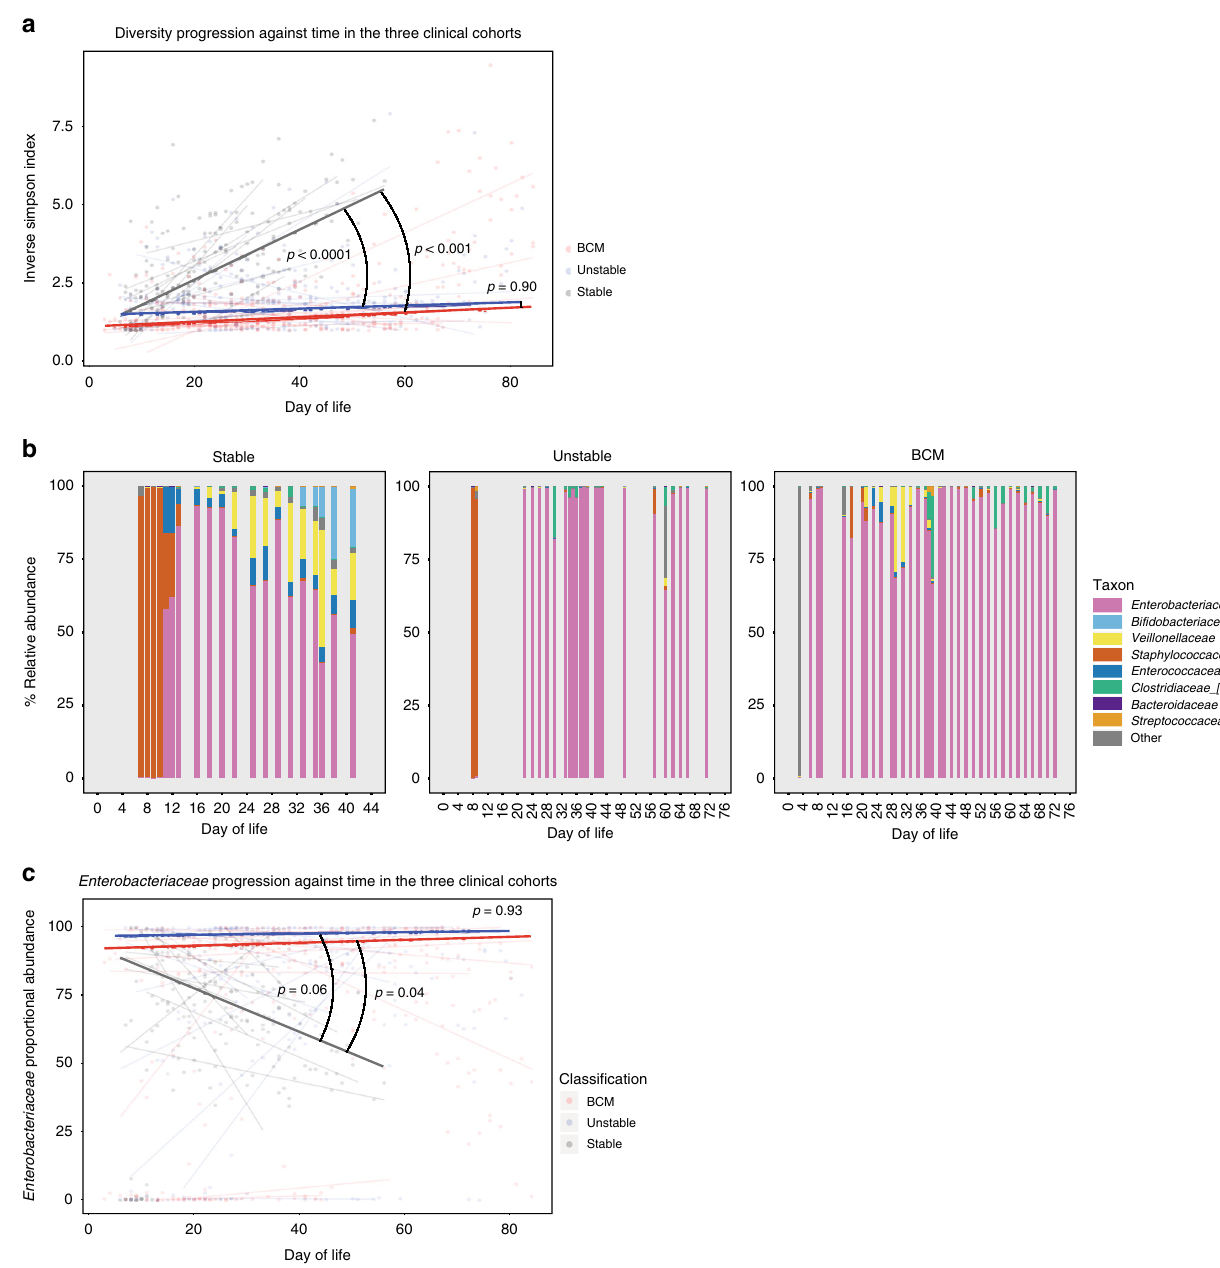
Fig. 4 Microbiome development. Faecal samples (713) were longitudinally collected from 34 babies across the duration of the study. Bacterial DNA was extracted, and the 16S rRNA gene (hypervariable region V4) was ampli fi ed, sequenced and compared against the sequence database to ascertain the relative abundance of bacterial taxa in samples. Participants were classi fi ed into three groups based on their clinical state: stable, unstable and those born to mothers with chorioamnionitis (BCM). a The progression of diversity against postnatal age across the three groups (stable — grey; unstable — blue; BCM — red). Dot plot represents individual sample diversity indices. Thin lines represent individual participants ’ regression coef fi cients through their diversity data points, as assessed by Theil – Sen estimator. Thick lines represent the median/mean of the individual trajectories within each clinical group. b Stacked bar charts of relative abundance of taxa in typical infants from the three clinical groups. Only taxa with >1% mean abundance across all samples are represented. c Enterobacteriaceae relative abundance against postnatal age across the three groups (stable — grey; unstable — blue; BCM — red). Dot plot represents individual sample Enterobacteriaceae proportions. Thin lines represent individual participants ’ regression coef fi cients through their Enterobacteriaceae proportions data points, as assessed by Theil – Sen estimator. Thick lines represent the median/mean of the individual trajectories within each clinical group. Source data are provided as a Source Data fi enhanced susceptibility to LPS-induced endotoxic shock 36 . The particular functional pro fi le 37 irrelevant of the cell type. It is only other factor that appeared to be sexually dimorphic was interesting, therefore, that expression was enhanced postnatally CD161 expression on CD8 T cells, which decreased in both male on NK cells and γδ T cells (where it correlated with IFN- γ pro- and female infants postnatally (albeit from an increased starting duction), but decreased on CD8 T cells. It is possible that some level in males). The expression of CD161 is thought to evoke a CD161 + CD8 + T cells represent mucosal-associated invariant T